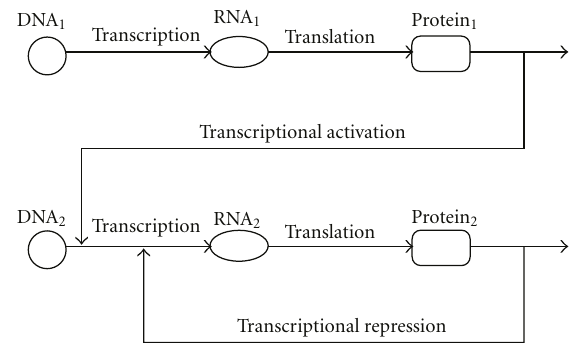
Figure 1: An illustration of a possible segment of a regulatory